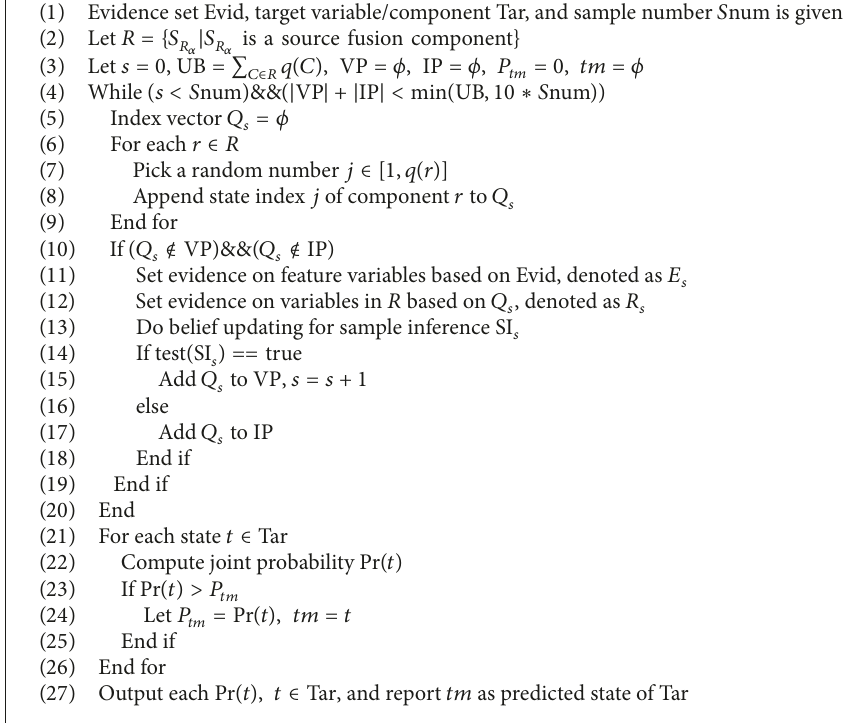
Algorithm 4: BKB updating by sampling